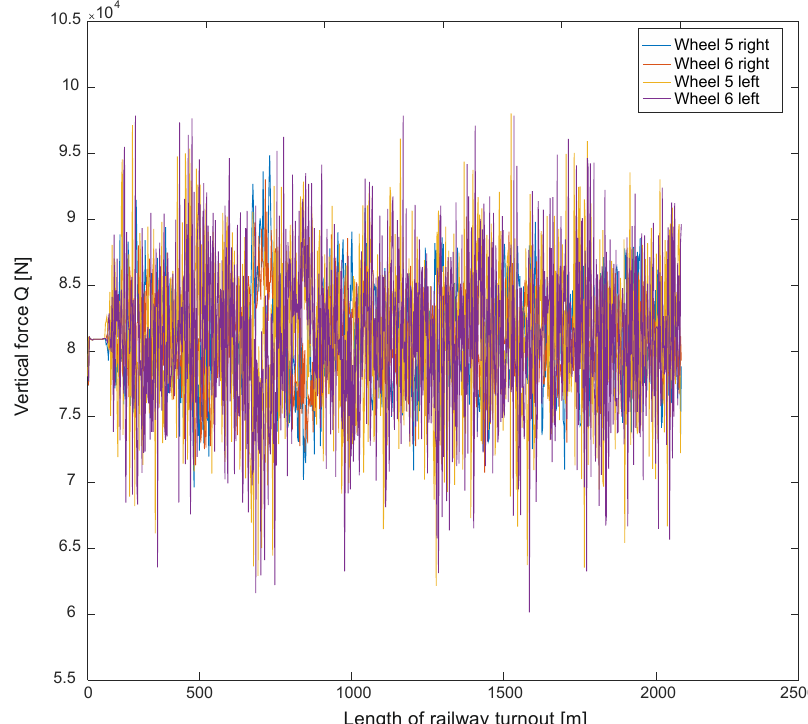
Figure 26 . Vertical force at 350 km/h on a straight track without a turnout .